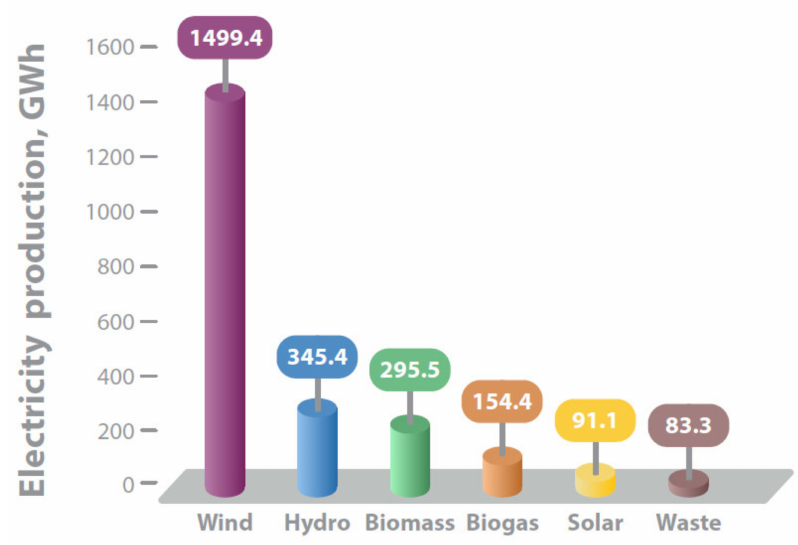
Figure 3. Electricity production from renewable energy sources in 2019. According to the Lithuanian Wind Power Association, there are currently 23 wind farms with a capacity of 480 MW in Lithuania, and a total of 546 MW of power plants have been installed, including individual wind farms (Table 1), and this number is growing every year. Table 1. Electricity capacity and generation